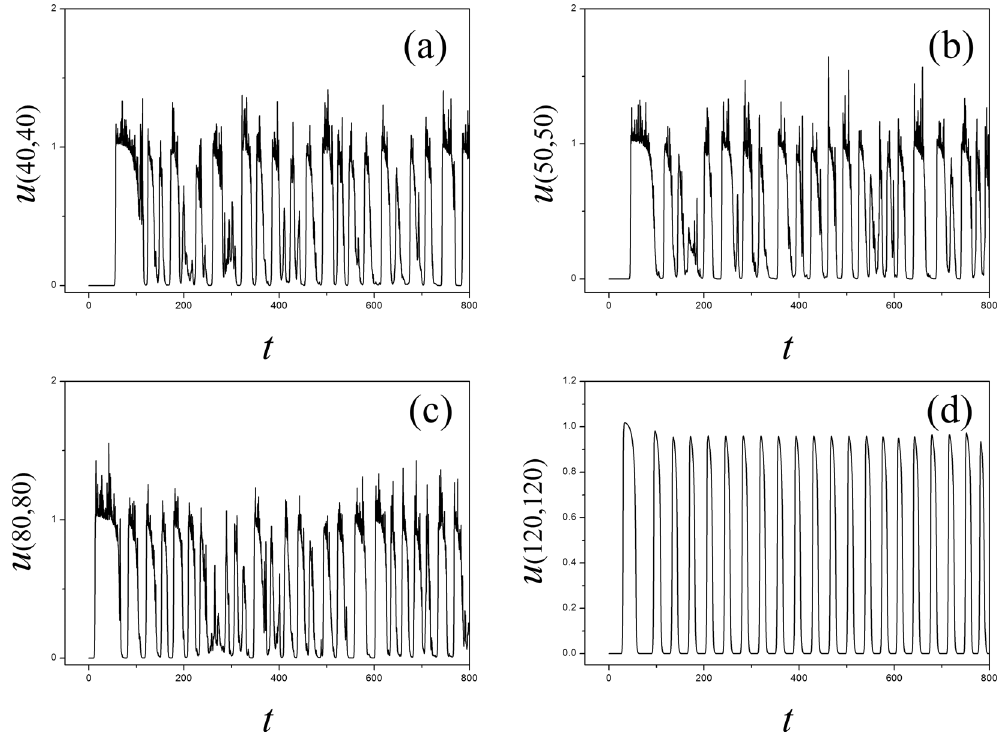
Figure 13. Sampled time series for membrane potentials on different nodes are calculated, and the center of area exposed to electromagnetic field is selected as ( x 0 , y 0 ) = (60, 60), noise area r ≤ 40, noise intensity is set as D = 9, k 0 = 0.1, k 1 = 0.5, k 2 = 1.6, α = 1, β =